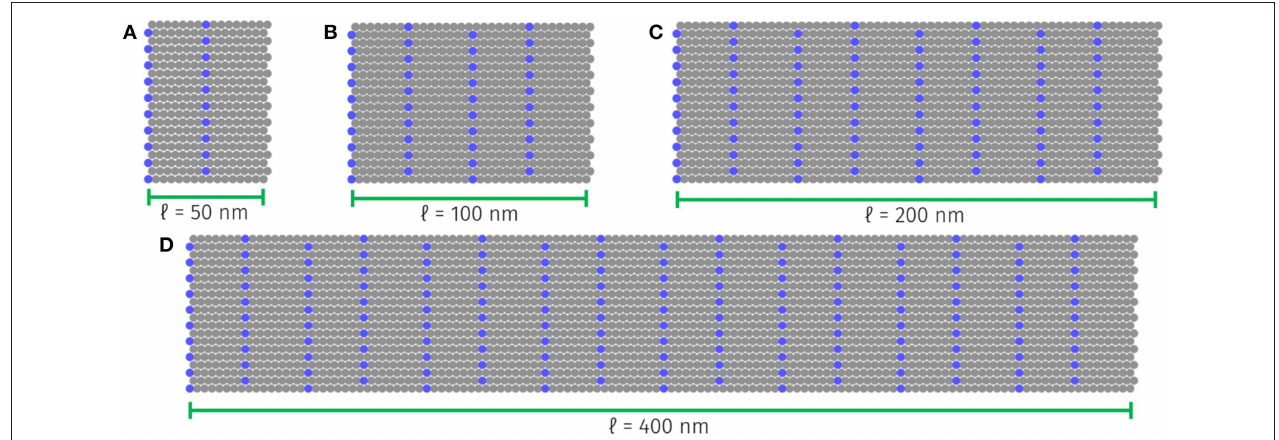
FIGURE 2 | Size scaled initial configurations of CNC films with (A) one, (B) two, (C) four, and (D) eight serial fibers in each periodic image. In each case, the individual fibers are equally sized ( L = 50nm), but the overall simulation axial length (l) is variable.